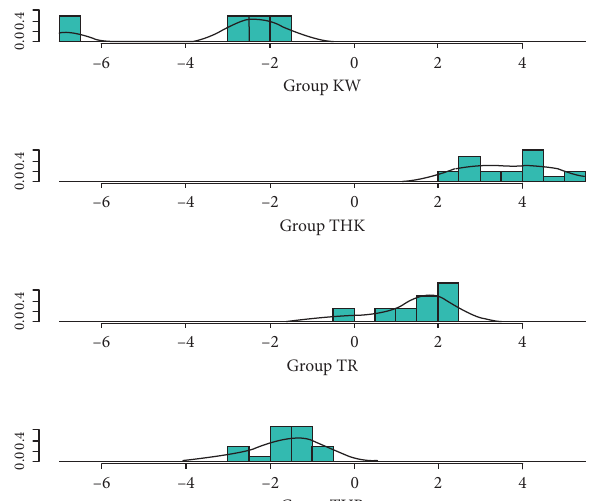
Figure 5: Separation between groups and overlapping areas that predict classes in doum palm using linear discriminant analysis. KW: Kwale. THK: Tharaka. TR: Tana River. TUR: